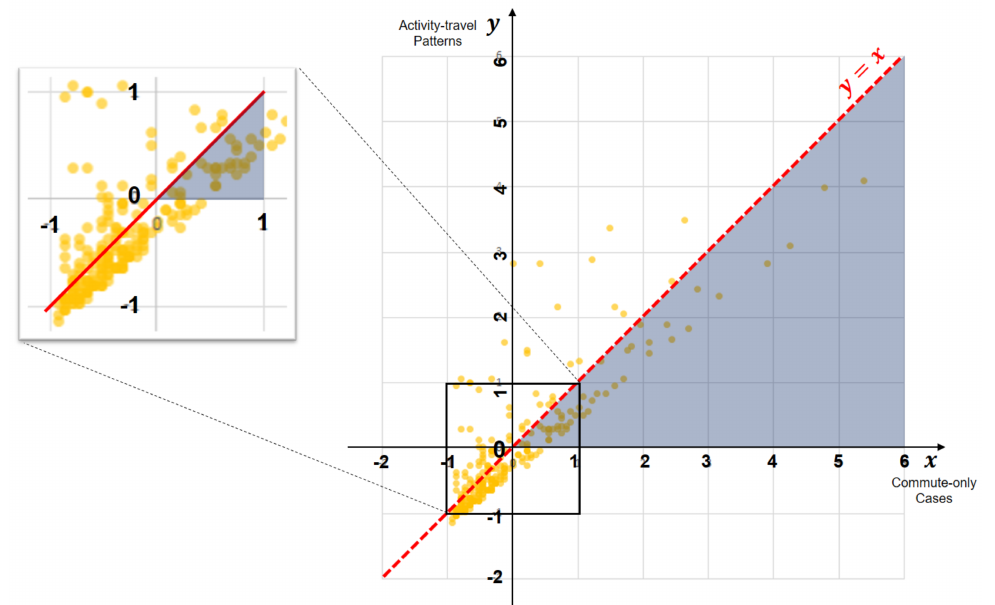
Figure 7. Standardized ( z -score) individual exposures to traffic